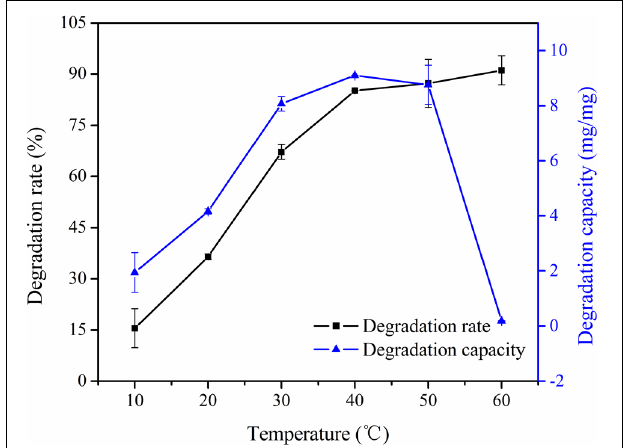
FIGURE 4 | Effect of temperature on degradation rate and degradation capacity of PPL for patulin.